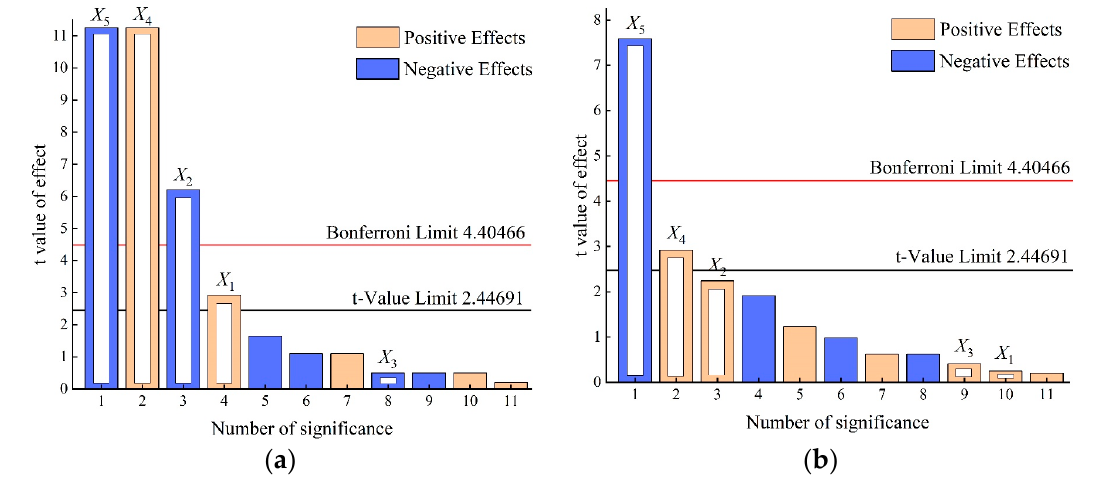
Figure 9. Pareto charts. ( a ) Breaking displacement. ( b ) Ultimate breaking force.